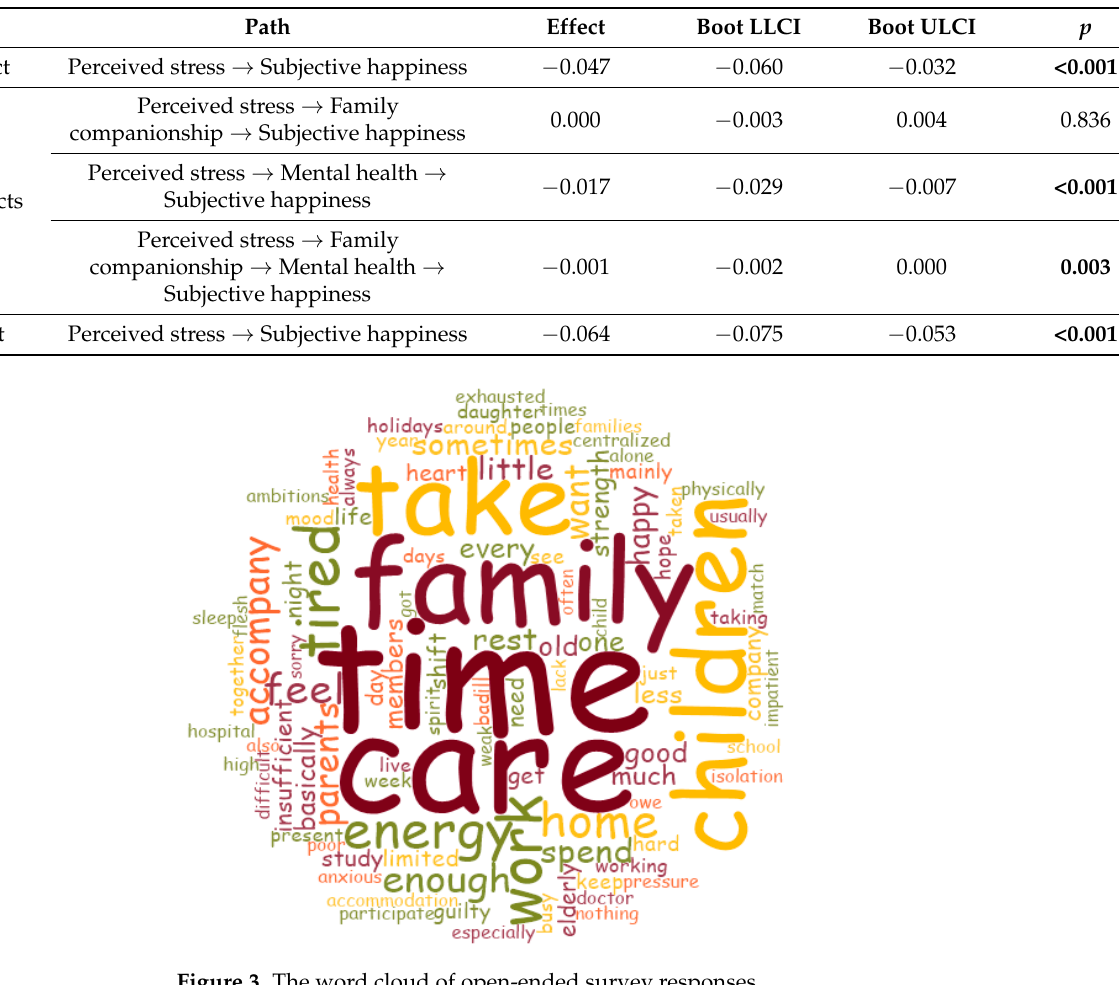
Figure 2. The role of family companionship and mental health as chain-mediators in the relationship between perceived stress and subjective happiness with standardized estimation (** p < 0.001). Table 5. Analysis of the chain-mediating effect of family companionship and mental health between perceived stress and subjective happiness.